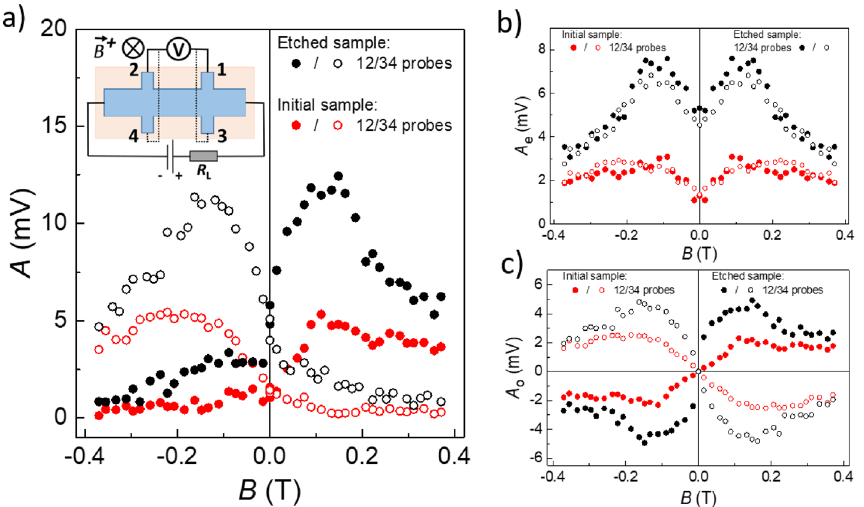
Figure 3. Magnetic field dependence of the positive photoconductivity amplitude. The panel ( a ) shows the magnetic field dependence of the positive photosignal component amplitude. The panels ( b ) and ( c ) represent the magnetic field dependencies of the even and odd parts of the positive photoconductivity, respectively. The measurements were taken between the 1–2 (solid dots) and 3–4 (open dots) potential leads [see the inset in the panel ( a )] in the initial (red dots) and etched (black dots) structures. Terahertz radiation frequency f = 1.07